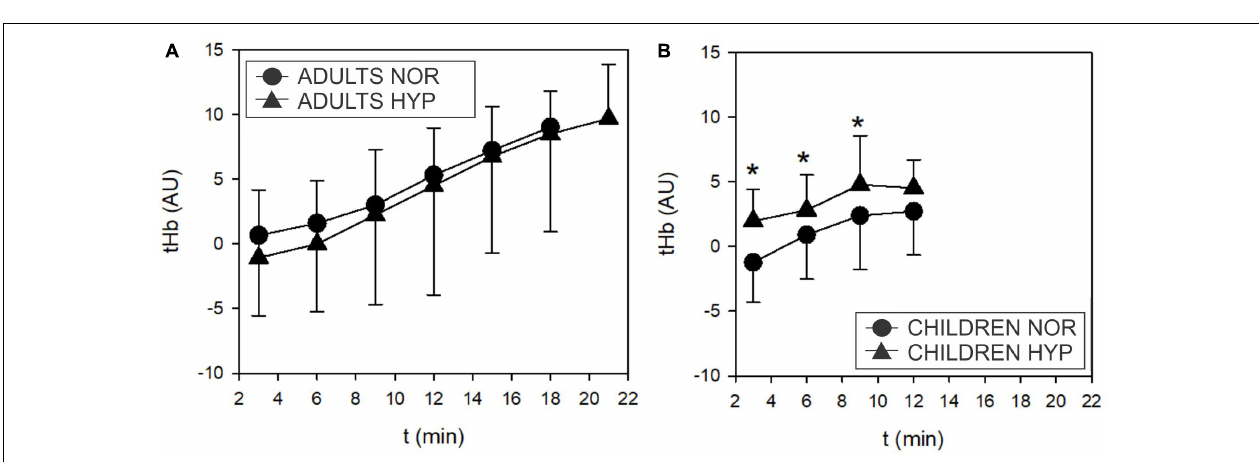
FIGURE 5 | Time course of the end tidal partial pressure of O 2 (P ET O 2 ) and CO 2 (P ET CO 2 ) responses during incremental test in adults (A,B) and children (C,D) . P ET O 2 decreased in hypoxia both, in adults ( (cid:78) ) and children ( (cid:49) ). P ET CO 2 decreased in hypoxia ( (cid:78) ; ∗ p < 0.05) above GET only in adults. Hypoxia didn’t seem to influence P ET CO 2 in children.